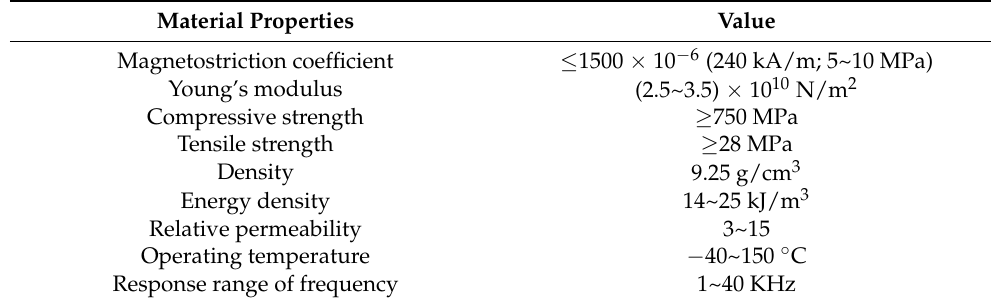
Table 2. Terfenol-D material properties.